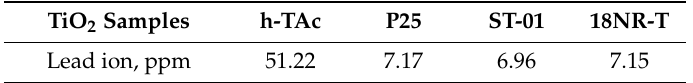
Figure S3: PL spectra of PVSC, PVSC-meso, and PVSC-hTAc85, Figure S4: Photocurrent density-voltage curves of PVSC-meso, Figure S5: SEM images of MAPbI 3 layers incorporated with various TiO 2 of 0.85-wt%: (a,b) h-TAc, (c,d) P25, (e,f) ST01, (g,f) 18NR-T, Figure S6: PL spectra of MAPbI 3 layers incorporated with di ff erent kinds of TiO 2 , Figure S7: Cross-sectional SEM image of PVSC-18NRT: Figure S8: FTIR spectra of h-TAc and Cross-sectional SEM image of PVSC-18NRT: Figure S8: FTIR spectra of h-TAc and P25.